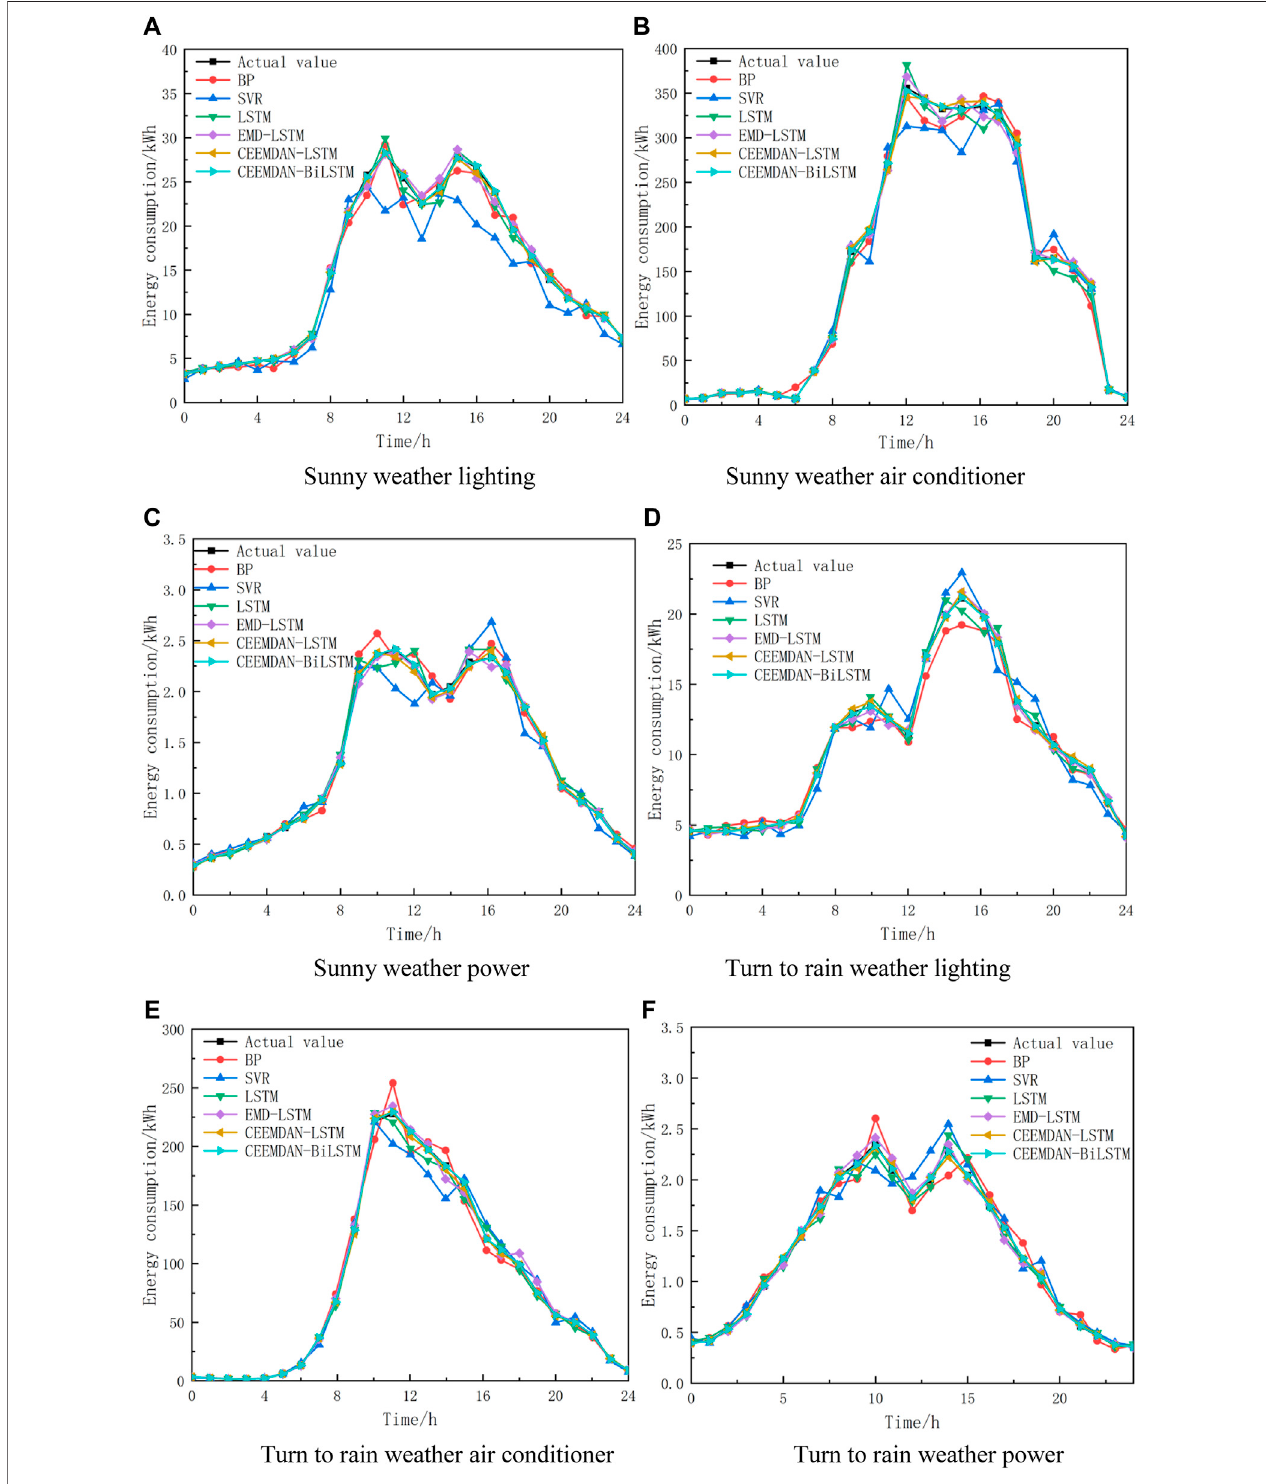
FIGURE3| Predictionresultsofdifferentmodels. (A) Sunnyweatherlighting. (B) Sunnyweatherairconditioner. (C) Sunnyweatherpower. (D) Turntorainweather lighting. (E) Turn to rain weather air conditioner. (F) Turn to rain weather power.